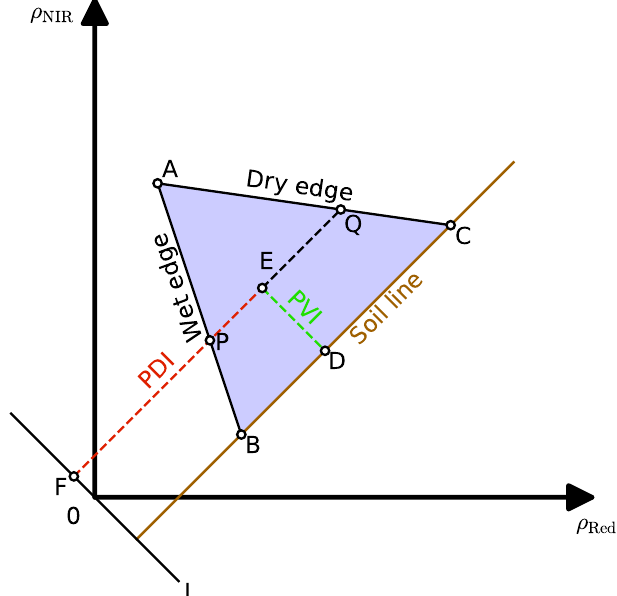
Figure 5. Sketch map of the NIR-Red reflectance space. The triangle ABC is the outline of the scatter points. A represents full vegetation cover. AB is the wet edge, representing the water-saturated status. AC is the dry edge, representing the extremely dry status. BC is the soil line, representing bare soil. E corresponds to the pixel value. Line L is the perpendicular line of BC that crosses the original. EF is the perpendicular line of L which crosses E. EF intersects with AB at P, while also intersecting AC at Q. ED is the perpendicular line of EF that crosses E and intersects with BC at D. The length of the segment EF is the PDI, and the length of the segment ED is the